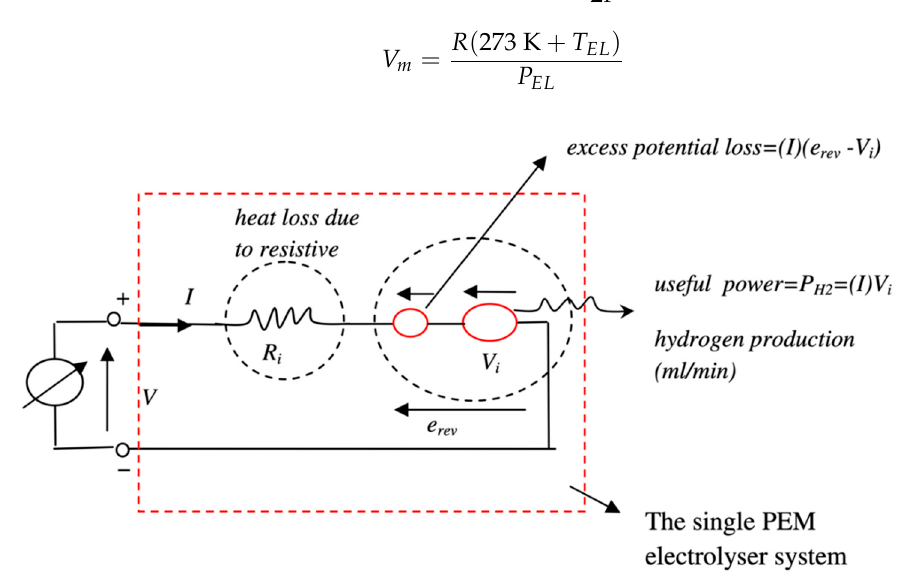
Figure 3. Equivalent circuit of the PEM electrolyser.